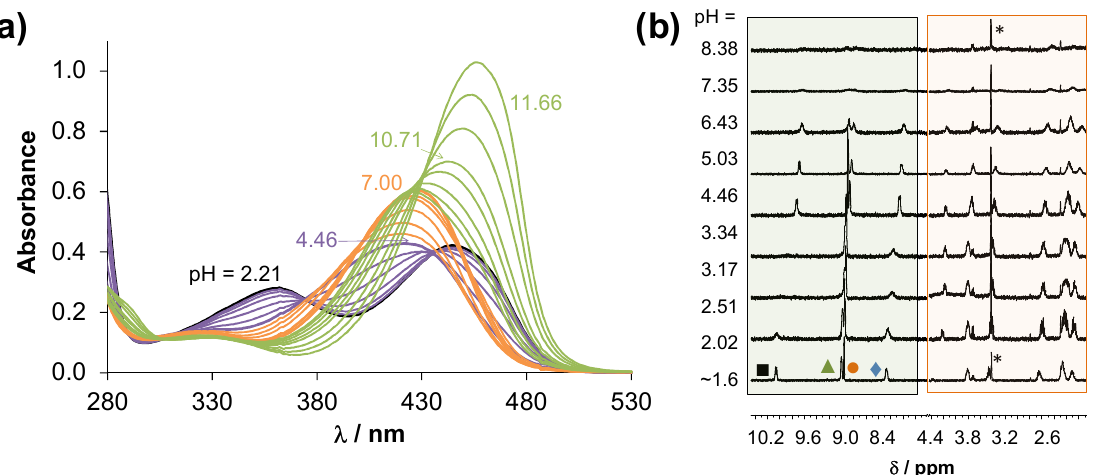
Figure 6. ( a ) UV-vis absorption spectra of the Zn(II)-HQNO 2 -L-Pro (1:2) system at various pH values. { c ligand = 40 μM; c Zn(II) = 20 μM. ( b ) 1 H NMR spectra recorded for the same system. Peak assignation is shown in Figure S9 and * denotes the solvent peak. { c ligand = 500 μM; c Zn(II) = 250 μM; I = 0.10 M KCl; t = 25.0 °C; 10% ( v / v ) D 2 O/H 2 O}. 1 H NMR spectra confirm the complex formation in the whole pH range (Figure